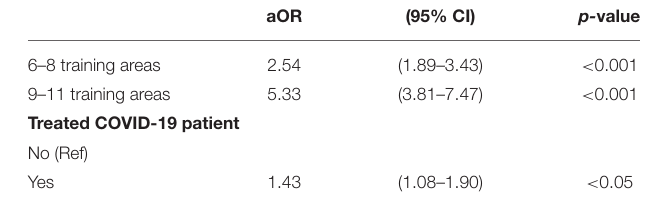
TABLE 3 | Multivariate logistic regression model of factors associated with confidence in overall knowledge about